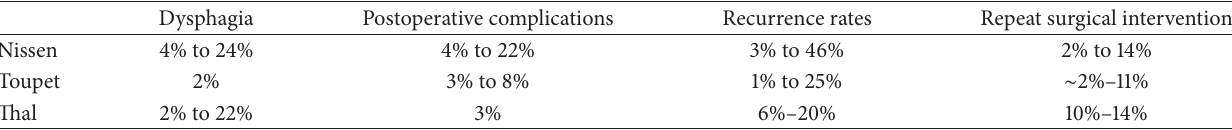
Table 5: Outcomes in antireflux surgery. Ranges based on retrospective reviews by Mattioli et al. [11], Chung and Georgeson [12], Steyaert et al. [13], and Subramaniam and Dickson [14] and randomized prospective study by Kubiak et al. [15]. Those categories with only one percentage value represent the only study that individually looked at a particular outcome category for either Nissen, Toupet, or Thal. Dysphagia Postoperative complications Recurrence rates Repeat surgical